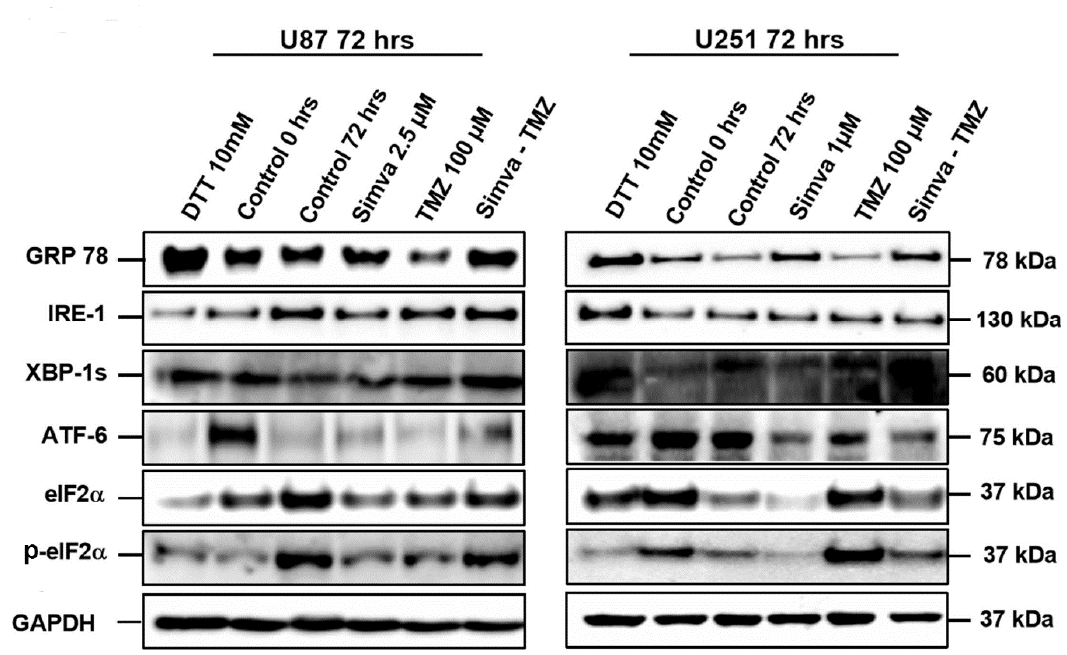
Figure 1. Simvastatin–temozolomide (Simva–TMZ) treatment induces unfolded protein response (UPR) concomitant with cell death and DNA damage in GBM cells. U87 and U251 cells were treated with TMZ, Simva, and Simva–TMZ for 72 h as described in the material and methods section. Cells were collected and lysed. The expression of protein markers of UPR (GRP-78, IRE-1, XBP-1s, ATF6, eIF2 α , and p-eIF2 α ) was determined by immunoblotting. glyceraldehyde-3-phosphate dehydrogenase (GAPDH) was used as the loading control. Simva–TMZ increased the protein amount of GRP-78, IRE-1, and XBP-1s, and it decreased the ratio of p-eIF2 α /eIF2 α as compared to the time-matched control. Immunoblots are representative of three different biological replicates.